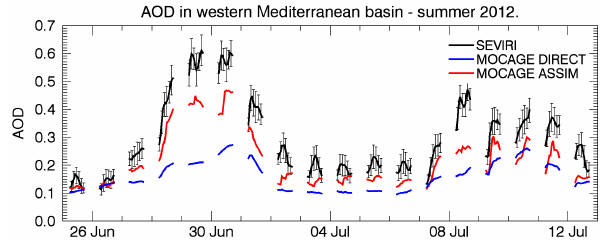
Figure 3. Hourly time series of aerosol optical depth at 550nm of SEVIRI data (black), the direct model (blue) and the assimila- tion model run (red) over the western Mediterranean (0–10 ◦ E, 35– 45 ◦ N) for the period of the TRAQA campaign from 25 June until 13 July 2012. The considered region is also marked in Fig. 5 by the grey box. Correlation, bias and root mean square error for both the direct model and the assimilation model run as compared to SEVIRI data are given in Table